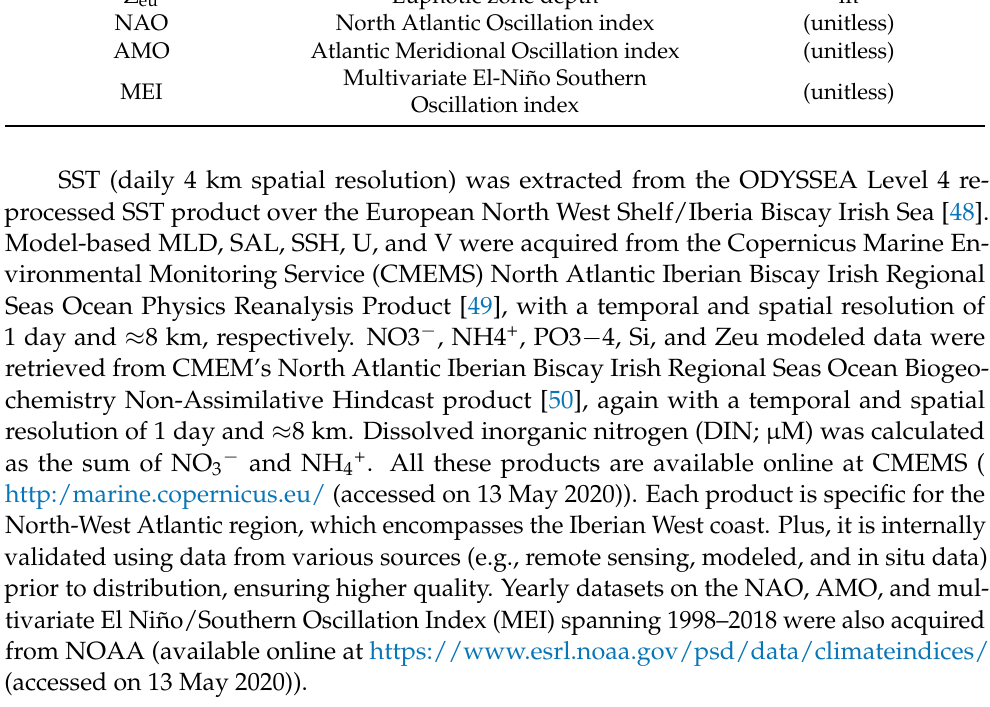
Table 2. Summary of the environmental variables and climate indices metrics used in this work. Metric Full Name Unit SST Sea surface temperature ◦ C MLD Mixed layer depth m SAL Salinity (unitless) SSH Sea surface height m V o Meridional component of water transport m s − 1 U o Zonal component of water transport m s − 1 Dissolved inorganic nitrogen (nitrate + µ M DIN ammonium) concentration PO 43 − Phosphate concentration µ M Silicon concentration µ M Z eu Euphotic zone depth m NAO North Atlantic Oscillation index (unitless) AMO Atlantic Meridional Oscillation index (unitless) Multivariate El-Niño Southern MEI Oscillation index